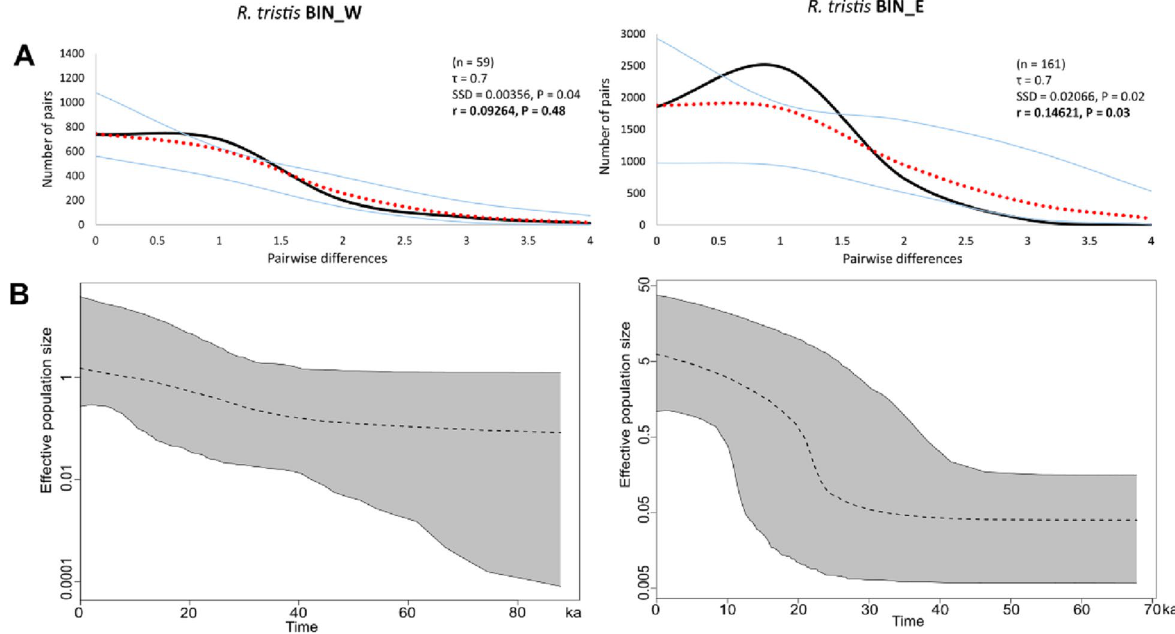
Figure 4. Historical demography of R. tristis populations in the W Carpathians. ( A ) Observed unimodal mismatch distribution of BIN_W and BIN_E suggests a recent population expansion. Each plot shows the number (Y axis) of pairwise nucleotide site differences (X axis) among sequences for each BIN. The fit to the demographic expansion model is evaluated by the SSD and the Harpending’s raggedness index (r). The solid black line corresponds to the observed frequency of pairwise differences, the dotted red line represents the pattern expected under a model of sudden demographic expansion. The blue lines are the upper and lower boundaries of the 95% confidence interval; ( B ) Changes in effective population size through time estimated by extended Bayesian Skyline plots, reconstructing the population size history using an evolutionary rate 0.0115 substitutions/site/Myr. The x-axis is depicted on a scale of thousands of years (ka), while Y-axis corresponds to the log mean effective population size. The dotted line represents the mean, while grey-shaded areas encompass 95% central posterior density.